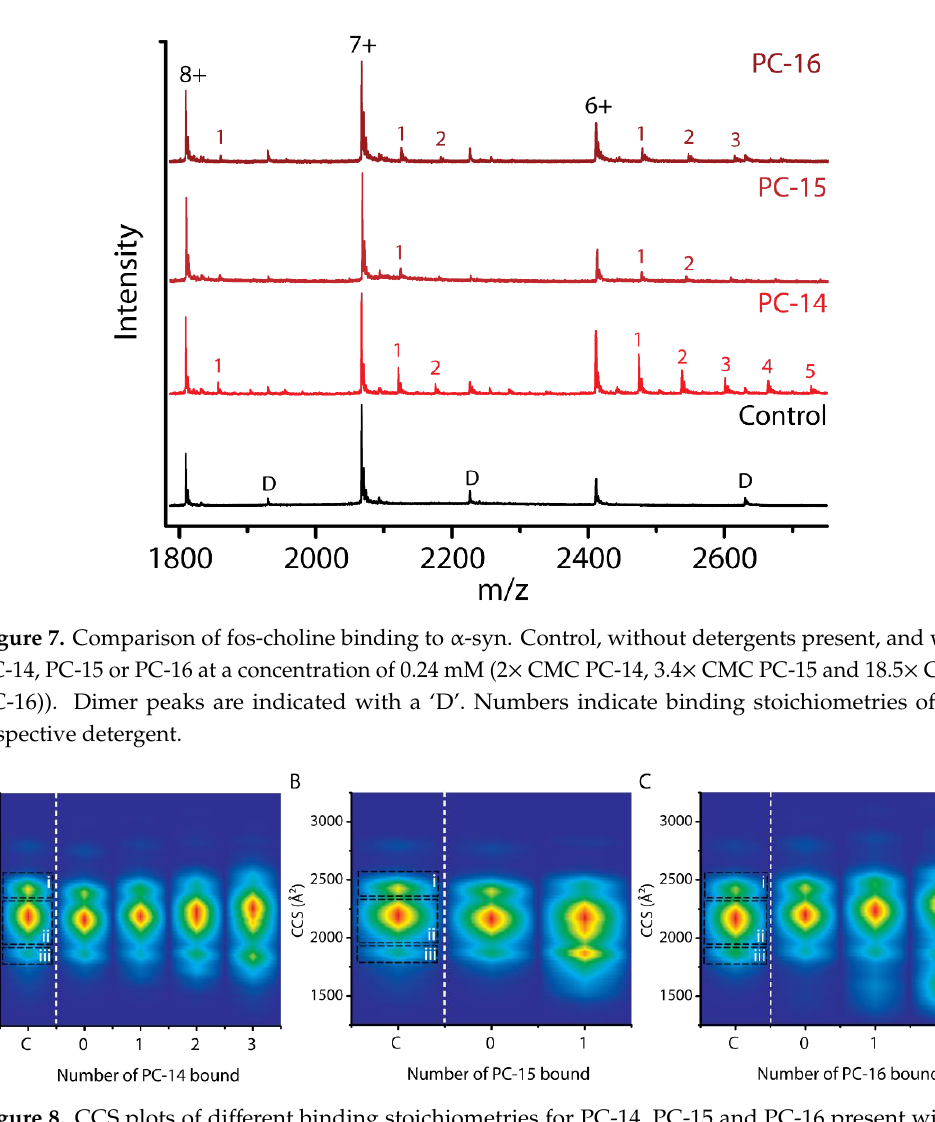
Figure 8. CCS plots of di ff erent binding stoichiometries for PC-14, PC-15 and PC-16 present with a concentration of 0.24 mM (2x CMC PC-14). ( A ) is identical to ( B ) of Figure 3. Conformational families “i” (more extended) to “iii” (more compact) are indicated in every sub-figure in the dashed boxes. ( C ) on the x-axis indicates the control, the unbound state of the 7 + charge state of α -syn without detergent present. “0” indicates the unbound state of the 7 + charge state of α -syn with detergent present. Intensities are scaled as described in the method